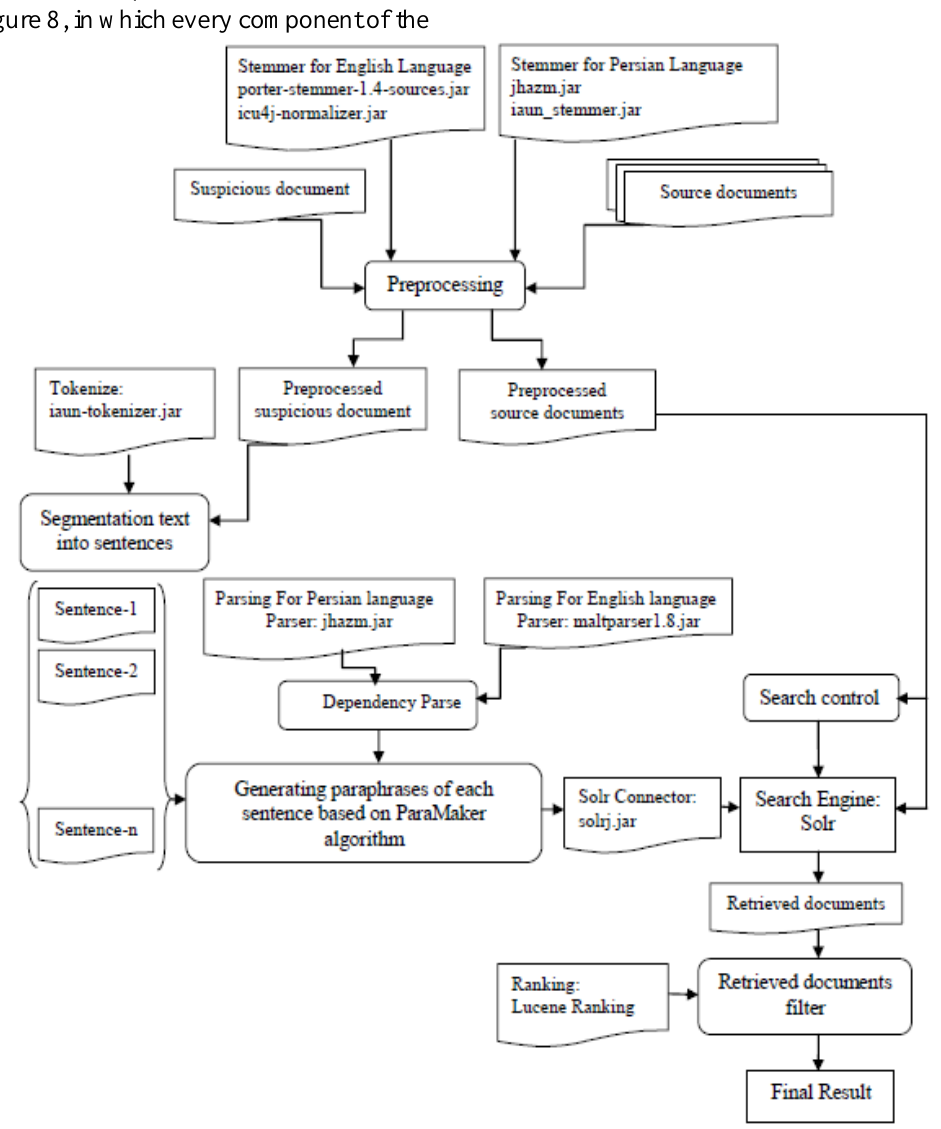
Figure 8. ParaMaker evaluation